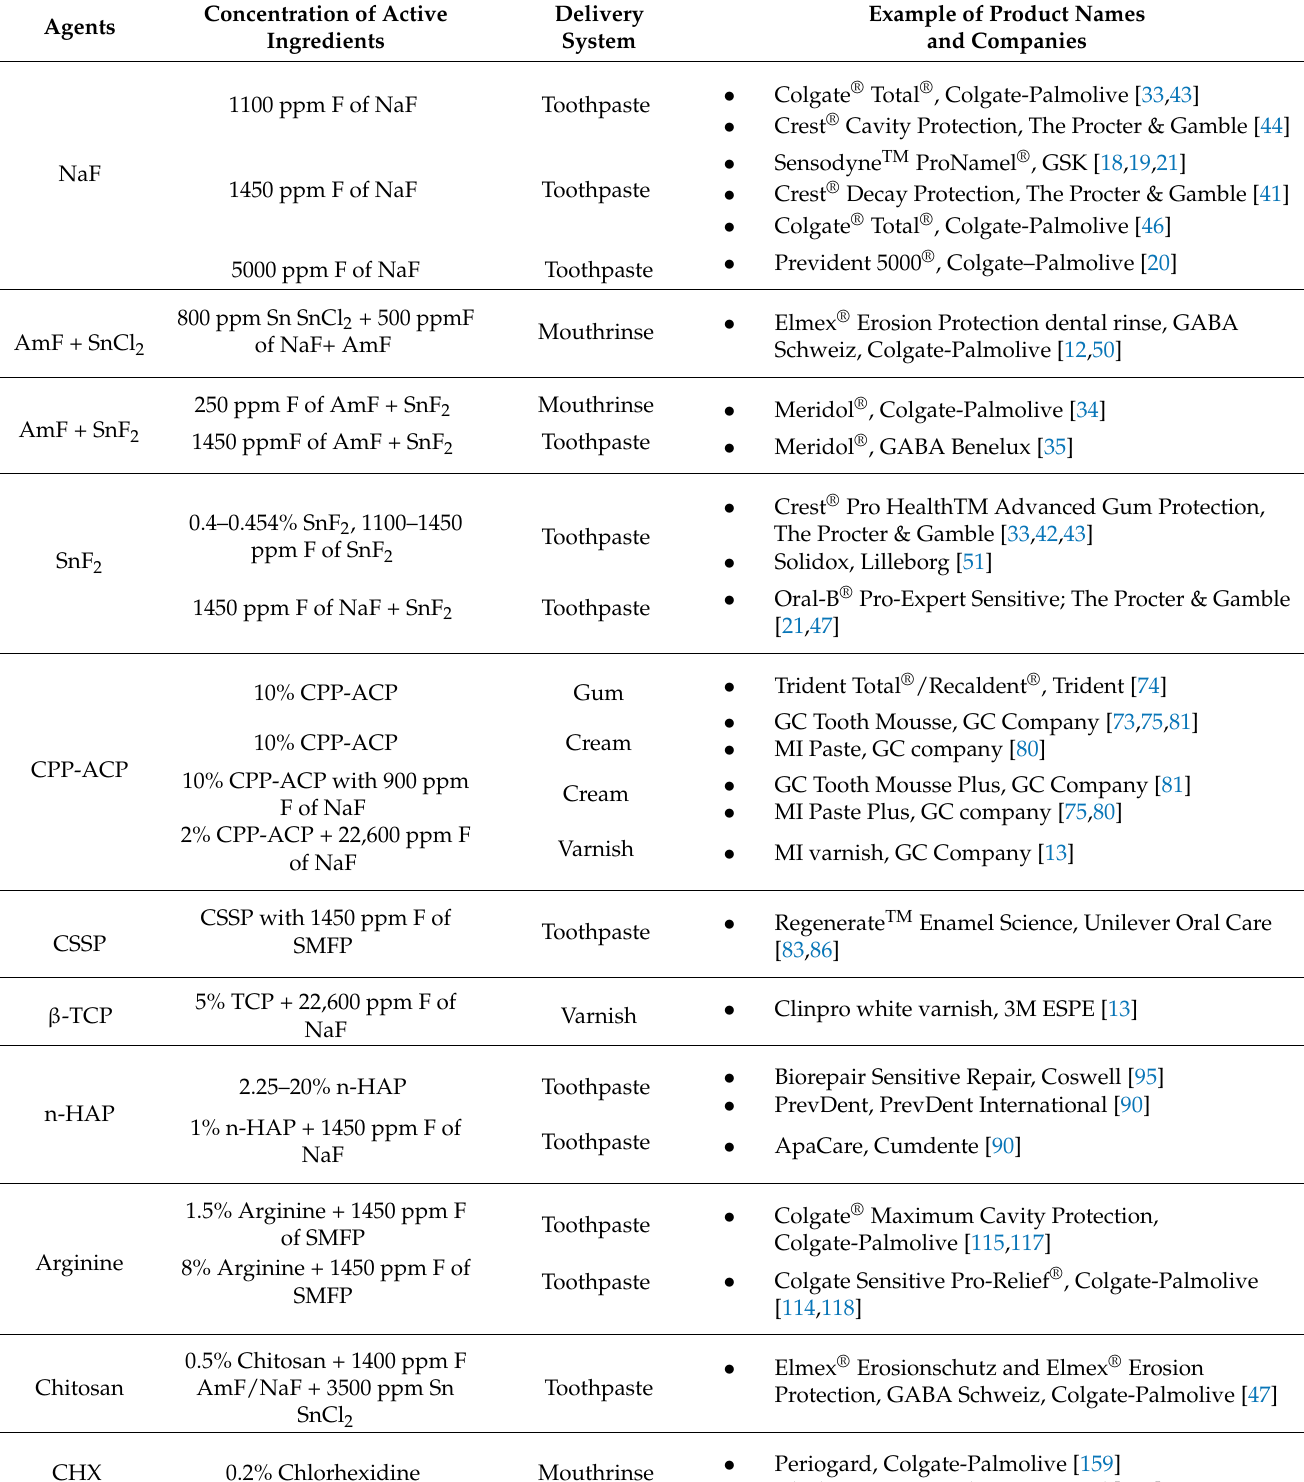
Table 1. Summary of commercially available anti-erosive agents in the